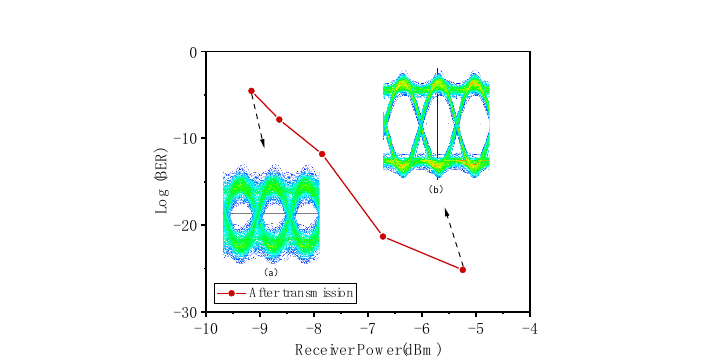
Fig. 4. BER performance of NRZ signal (the first signal); (a) The eye diagram when BER is 2.85e-5; (b) The eye diagram when BER is